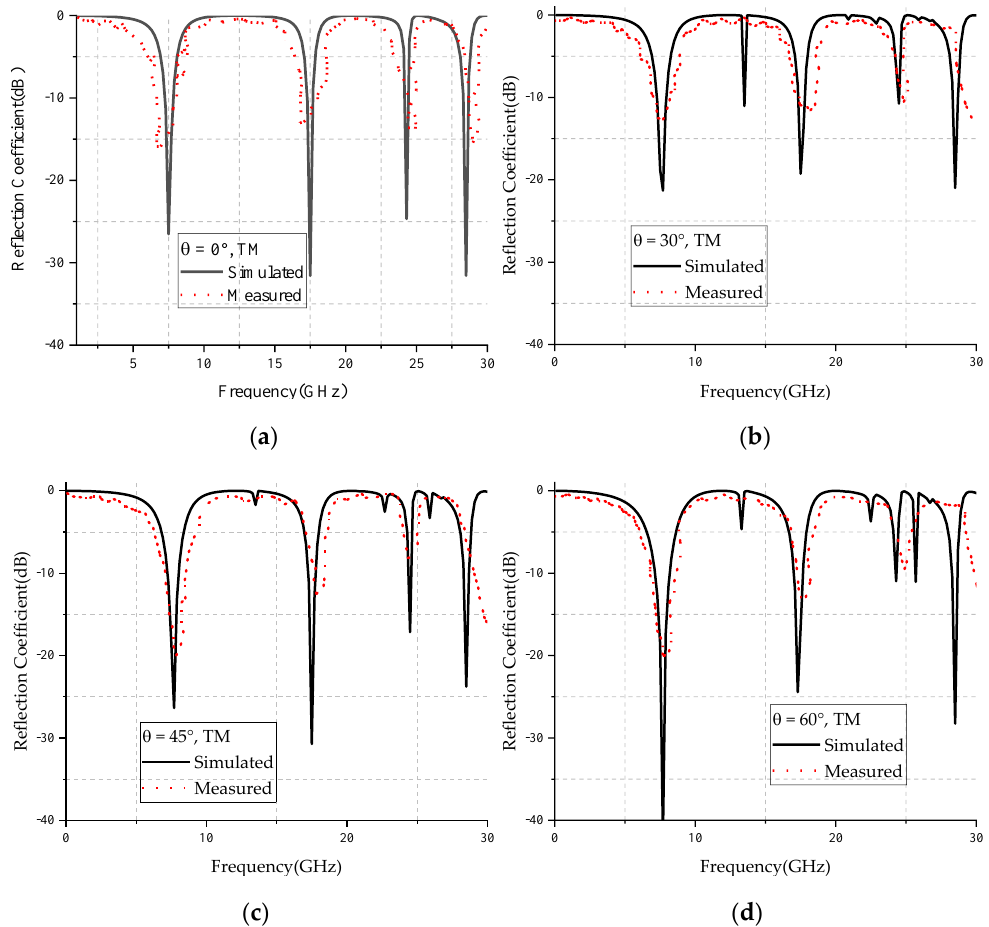
Figure 14. Comparison of simulated and measured results of TM wave incidence at: ( a ) 0 degrees, ( b ) 30 degrees, ( c ) 45 degrees, ( d ) 60 degrees.